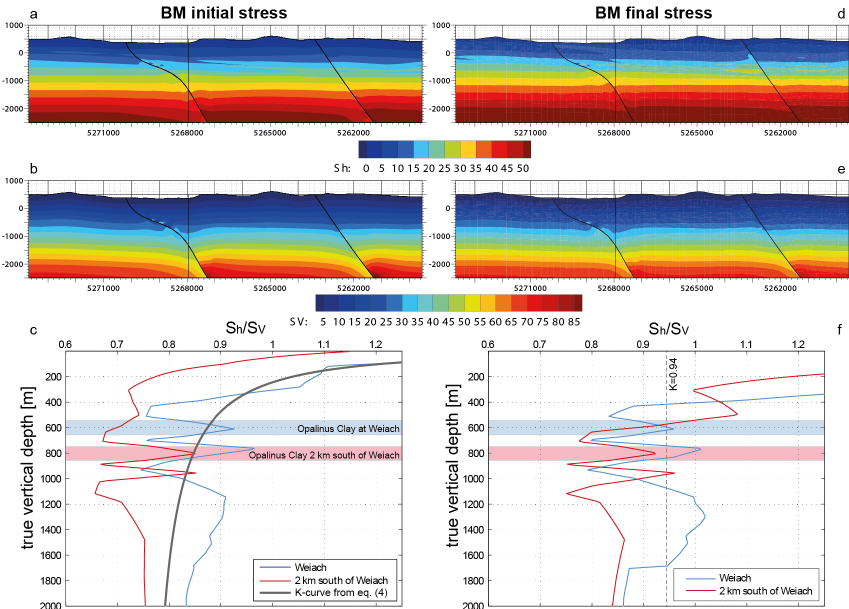
Figure 7. Magnitude of S h (first row) and S V (second row) on a north–south cross section through the Weiach well and K = S h /S V on depth profiles at the location of the Weiach well and 2000m south of it (third row) of initial (left column) and final stress (right column) of the base model (BM). Note that initial stress state is without tectonic boundary conditions and final stress state with tectonic boundary conditions applied. The grey line in (c) corresponds to the line in Fig. 5b, i.e. Eq. (4). Dashed line in (f) marks the value K = 0 . 94, which is derived